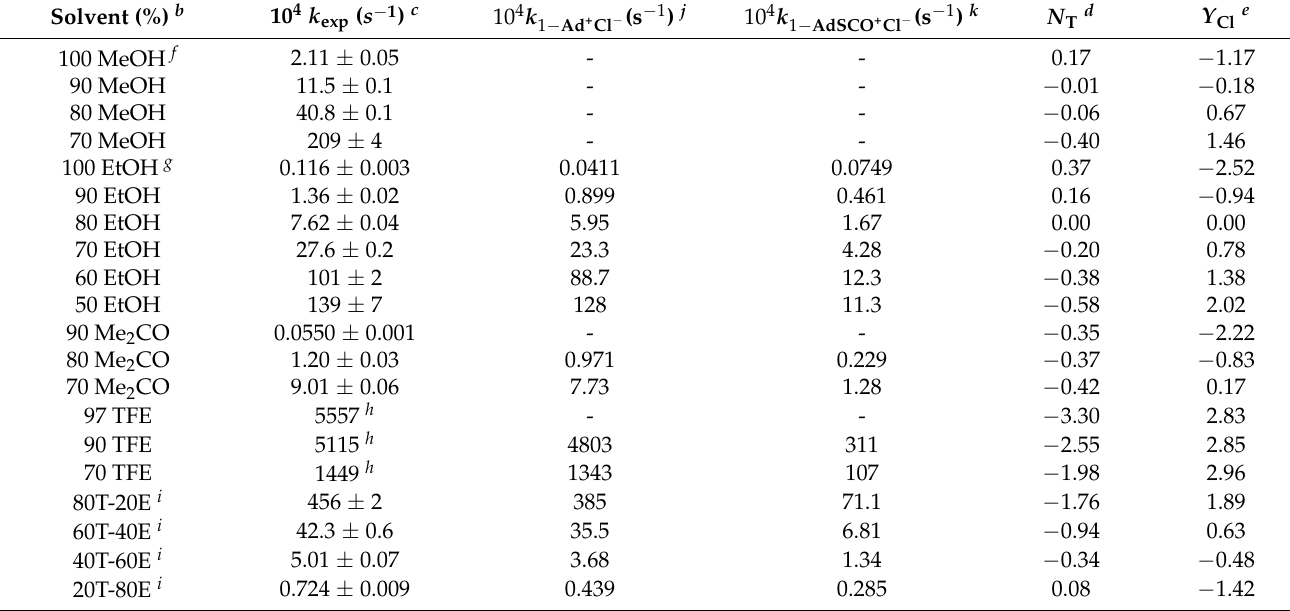
Table 1. Rate constants ( k exp ) of solvolysis of 1-adamantyl chlorothioformate ( 1 ) a in pure and binary solvents at 25.0 ◦ C, together with the appropriate solvent nucleophilicity ( N T ) and solvent ionizing power ( Y Cl ) values and the rate constants separated into 1-Ad + Cl − and (1-AdSCO) + Cl − for solvolyses of 1 at 25.0 ◦ C. Solvent (%) b 10 4 k exp ( s − 1 )